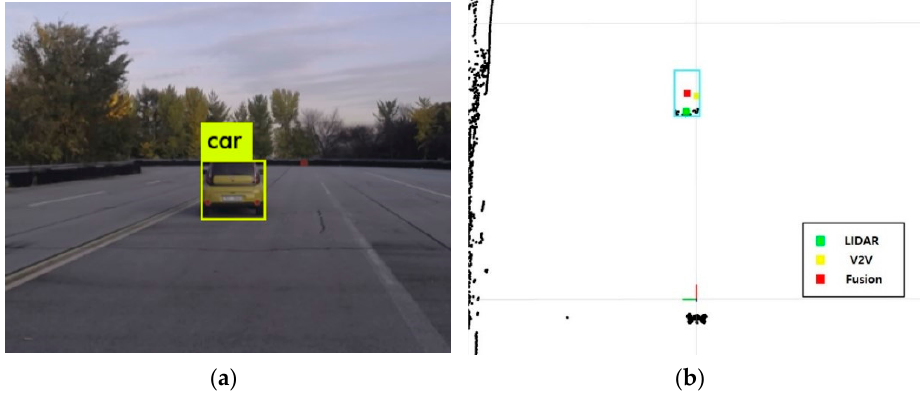
Figure 13. Perception system result. ( a ) Bounding box obtained from camera sensor; ( b ) estimated location of SV obtained by fusion of LIDAR and V2V communications.